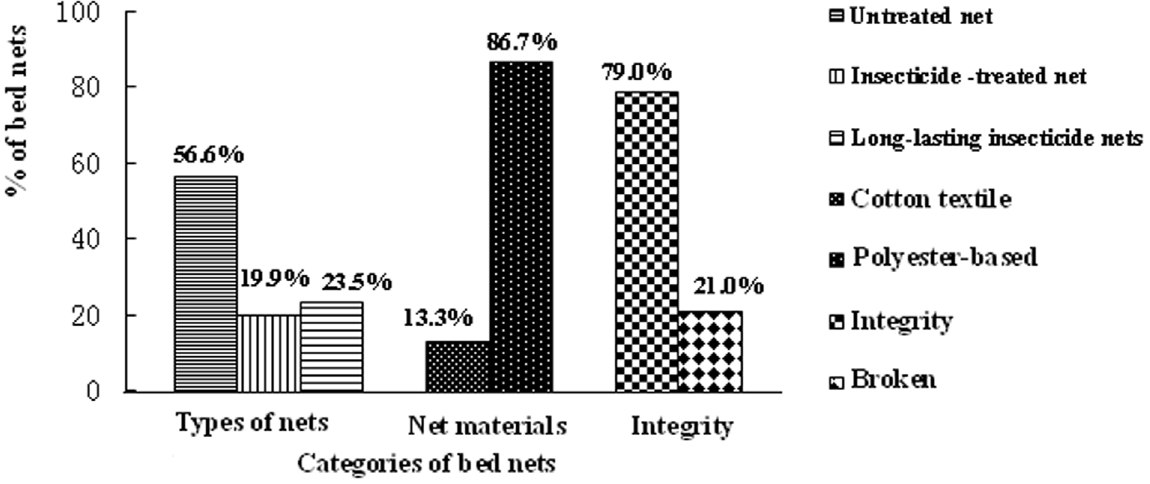
Figure 2. Percentage for categories of bed nets in Jinuo Ethnical Minority, Yunnan Province, China.